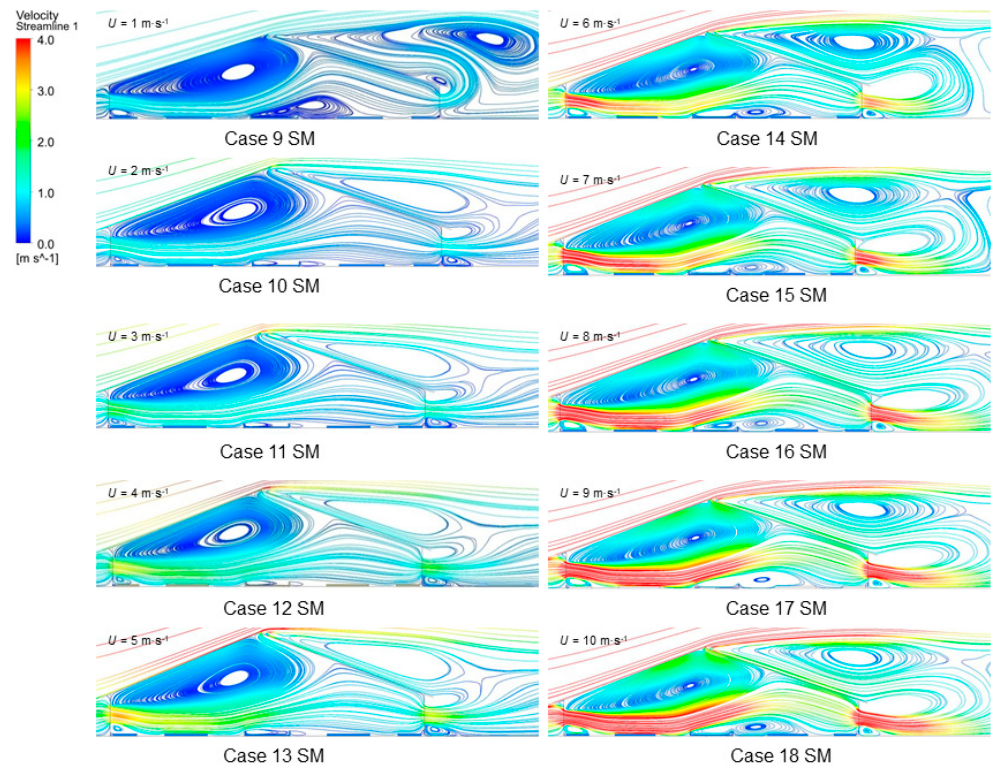
Figure 10. Airflow patterns inside and outside of the NVD barn for the inlet velocity of 1 to 10 m · s − 1 . SM—Middle part of the sidewall is open.